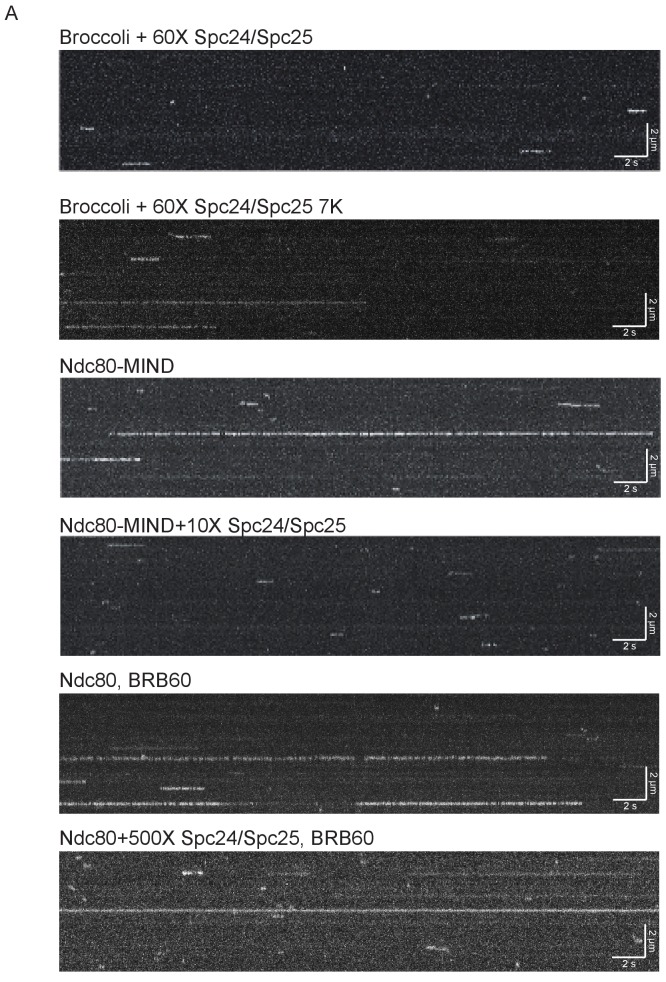
Representative kymographs of TIRF microscopy assays.(A) Representative kymographs of each condition measured in Figure 1B,C. Brightness and contrast have been adjusted separately for each image for best visualization.